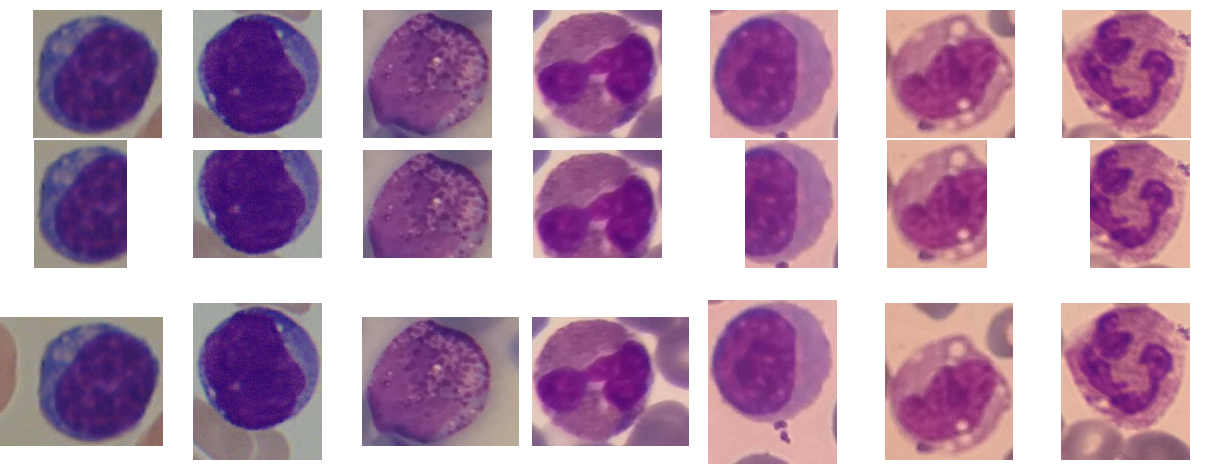
Figure 4. Tight ( top ), eroded ( middle ) and dilated ( bottom ) versions of ALL-IDB2 (first two columns) and R-WBC (remaining columns) data